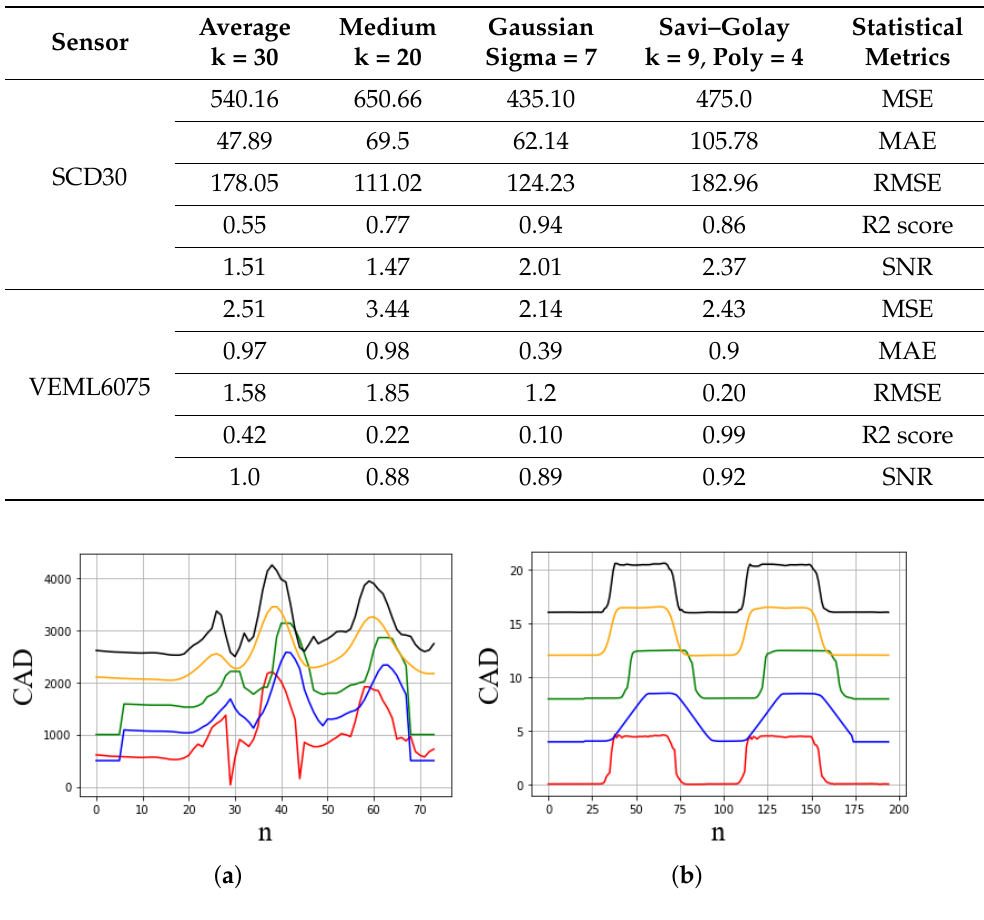
Table 6. Communication protocol sensors’ statistical analysis.